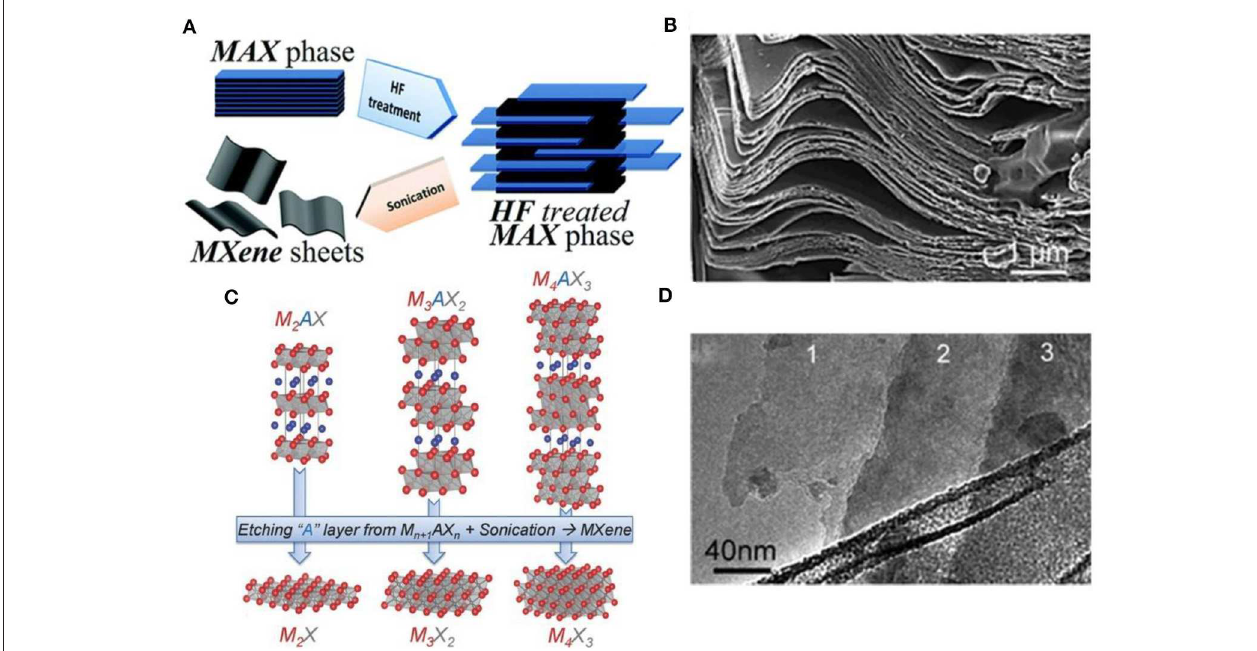
FIGURE 2 | (A) Schematic for the exfoliation process of MAX phases and formation of MXenes; (B) The image of the multi-layer of MXenes; (C) Structure of MAX phases and the corresponding MXenes; reproduced from Naguib et al. (2013) with permission from WILEY-VCH Verlag GmbH & Co. (D) The image of the single-layer of MXenes. (A,B,D) are reproduced from Naguib et al. (2012) with permission from American Chemical